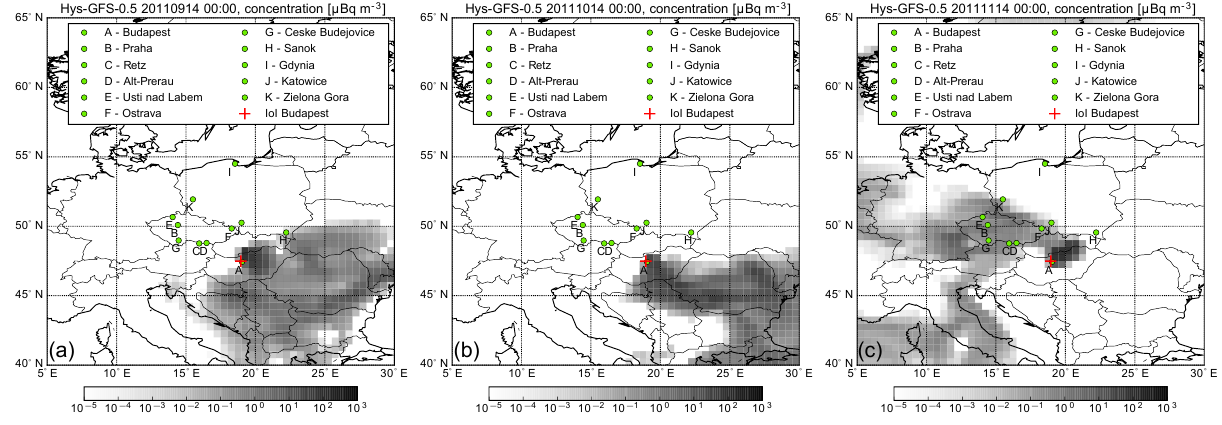
Figure 6. Maps of daily concentrations of 131 I for selected days (dates are reported at the top of each panel, 14 September in a , 14 October in b , and 14 November in c ) using the HYSPLIT model with GFS input data with 0.5 ◦ resolution and with the source term computed using the LS-APC-VB algorithm given in Fig. 3, top